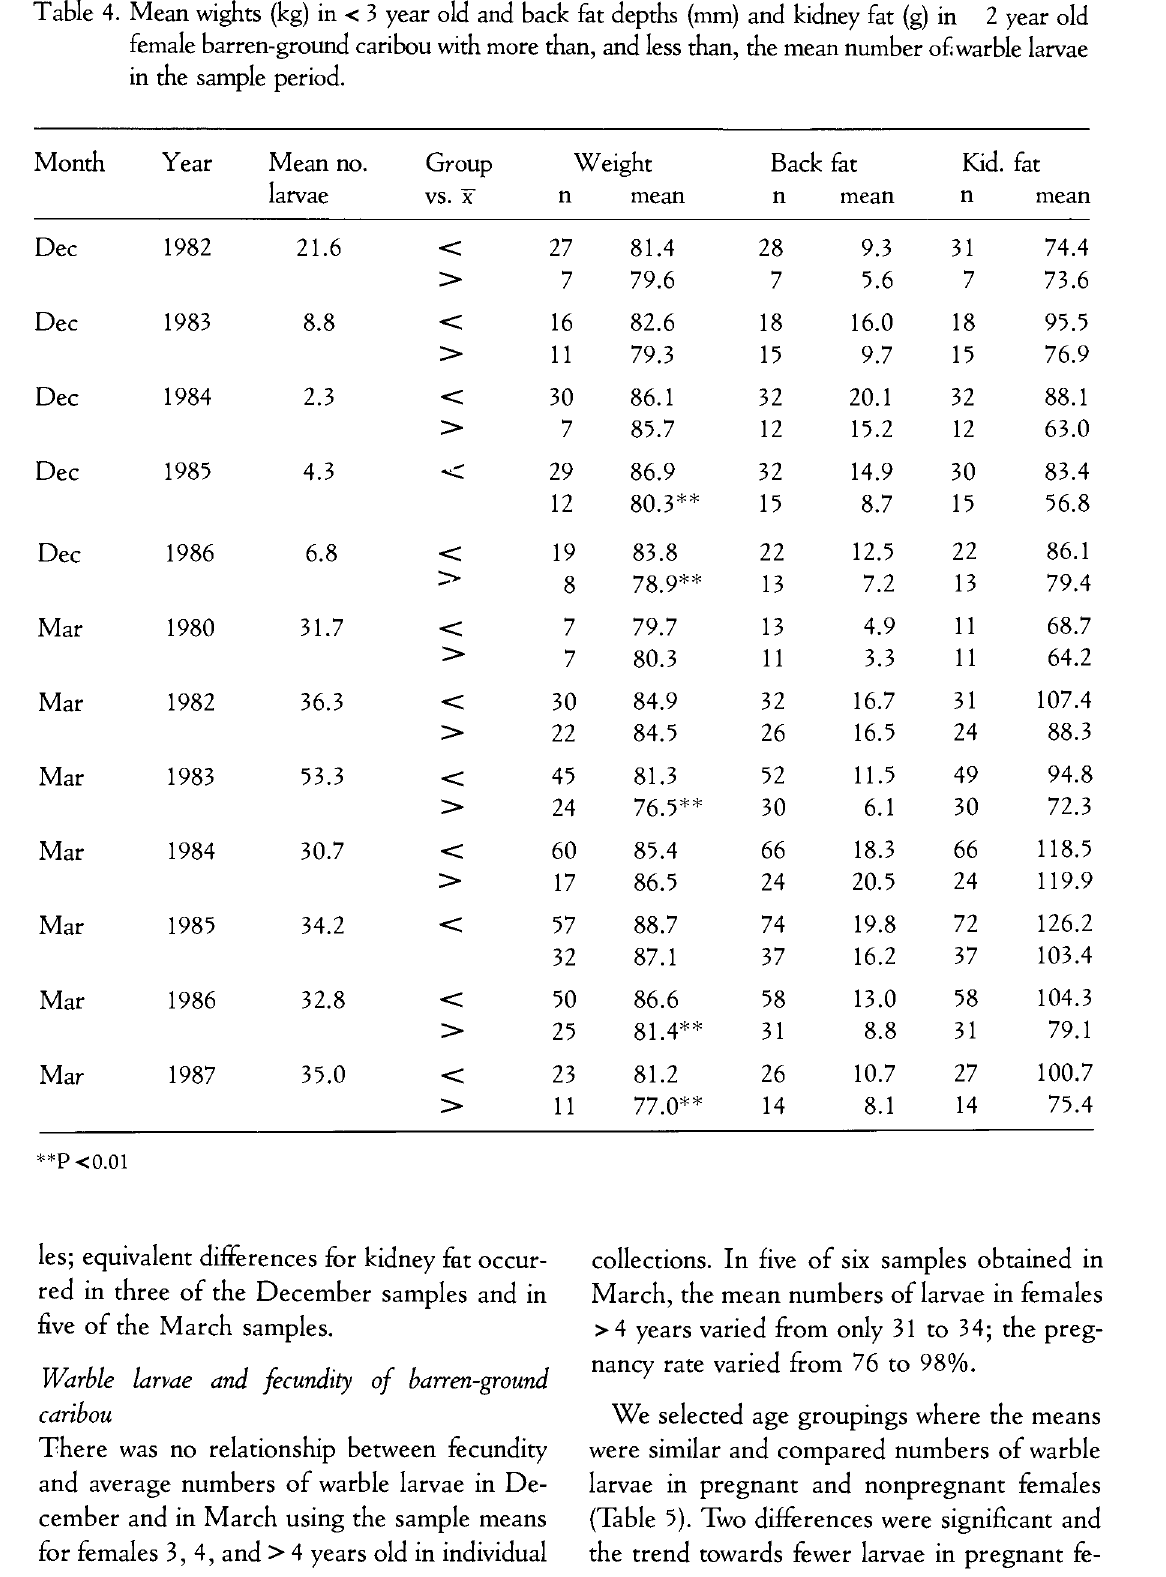
Table 4. Mean wights (kg) in < 3 year old and back fat depths (mm) and kidney fat (g) in 2 year old female barren-ground caribou with more than, and less than, the mean number of warble larvae in the sample